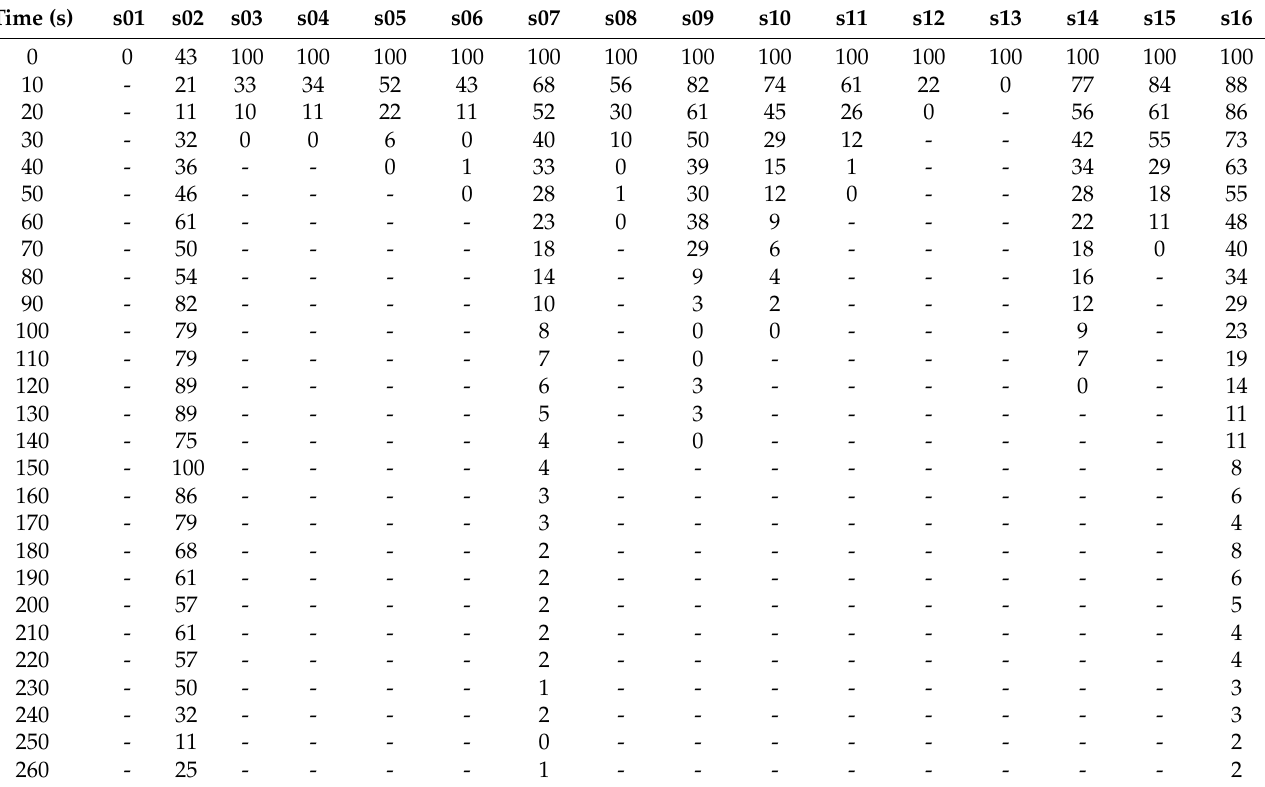
Table A1. Normalized foam height (%) determined by performing image analysis on RGB videos of 16 beer